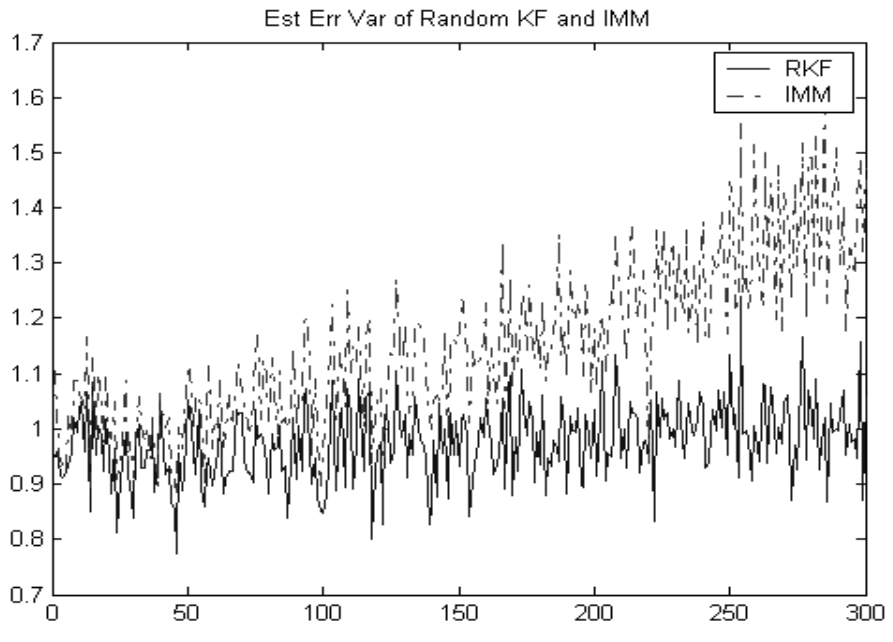
Figure 3. Comparison of IMM and random Kalman